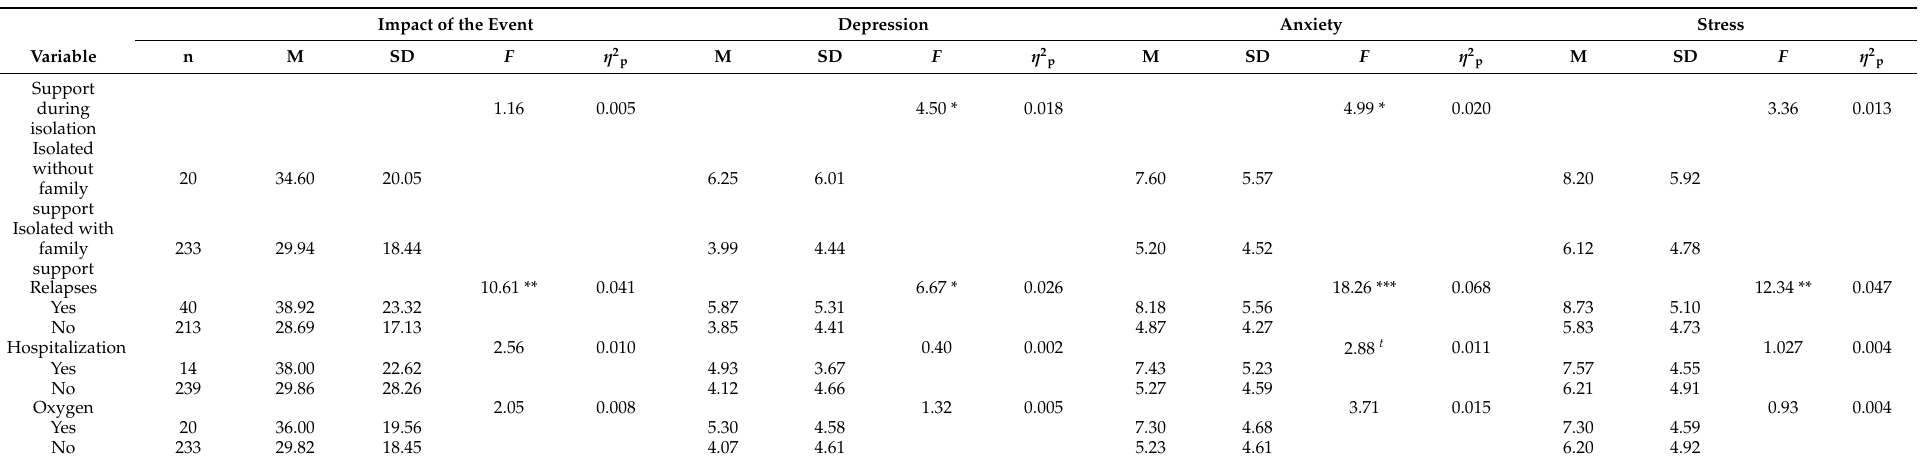
Table 3. Mental health of the COVID-19 survivors as a function of the disease. Impact of the Event Depression Anxiety Stress